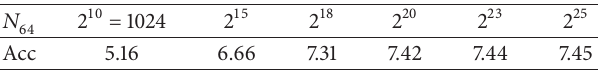
Table 7: The results of experiments (data are transmitted through four 64-bit high-performance ports and one 64-bit